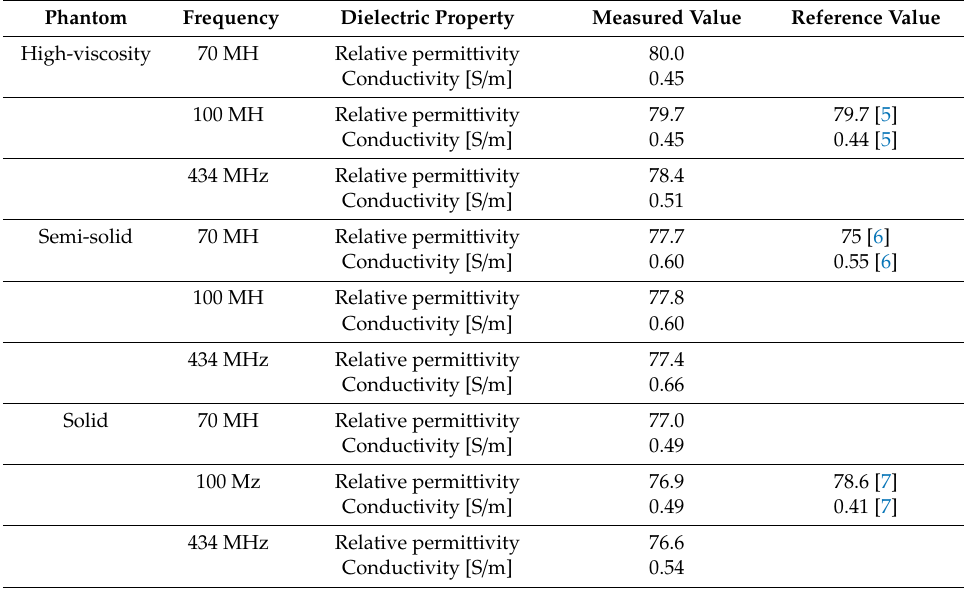
Table 2. Dielectric assessment of the phantoms at the frequencies of interest (70 MHz, 100 MHz and 434 MHz).